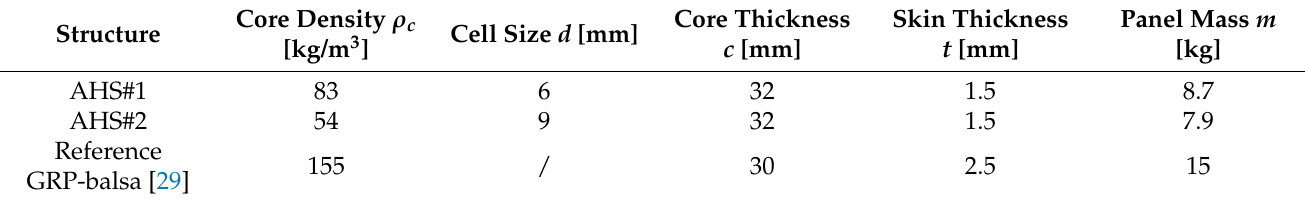
Table 1. Properties of the tested AHS panels and the reference